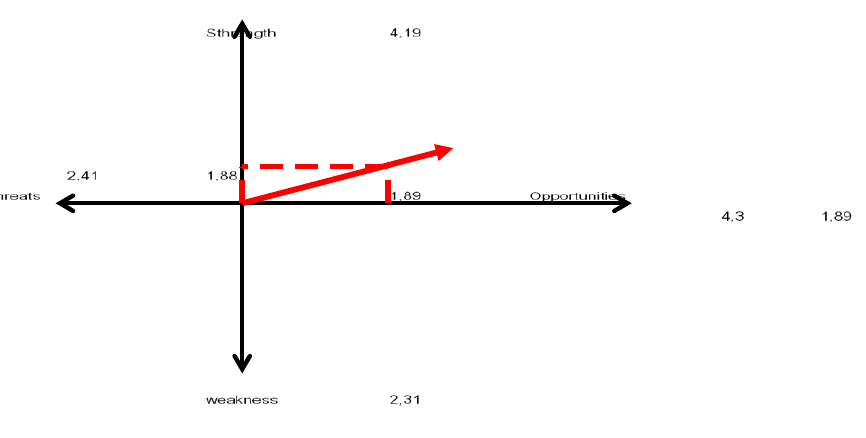
Figure 3. Vector direction SWOT Analysis Results Papuan Case Source: Data processed in